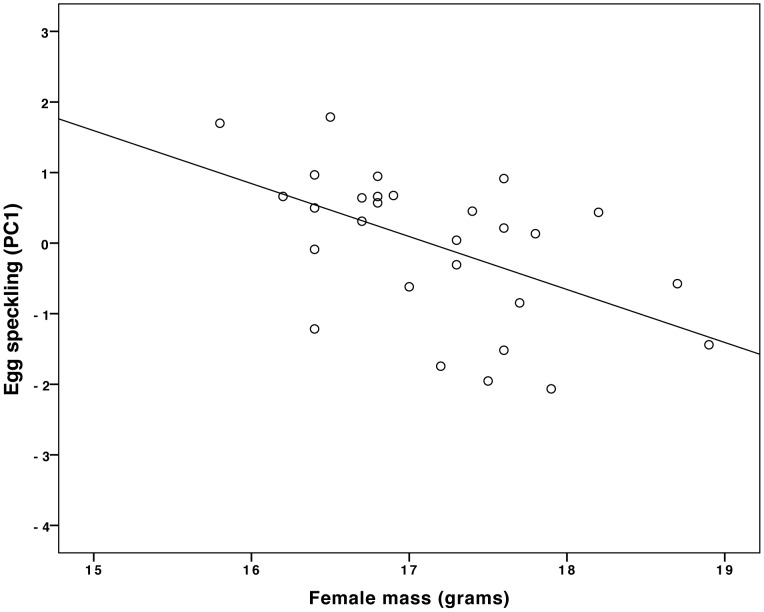
Heavier females laid less speckled eggs (PC1).N = 28 nests (see text for statistics).